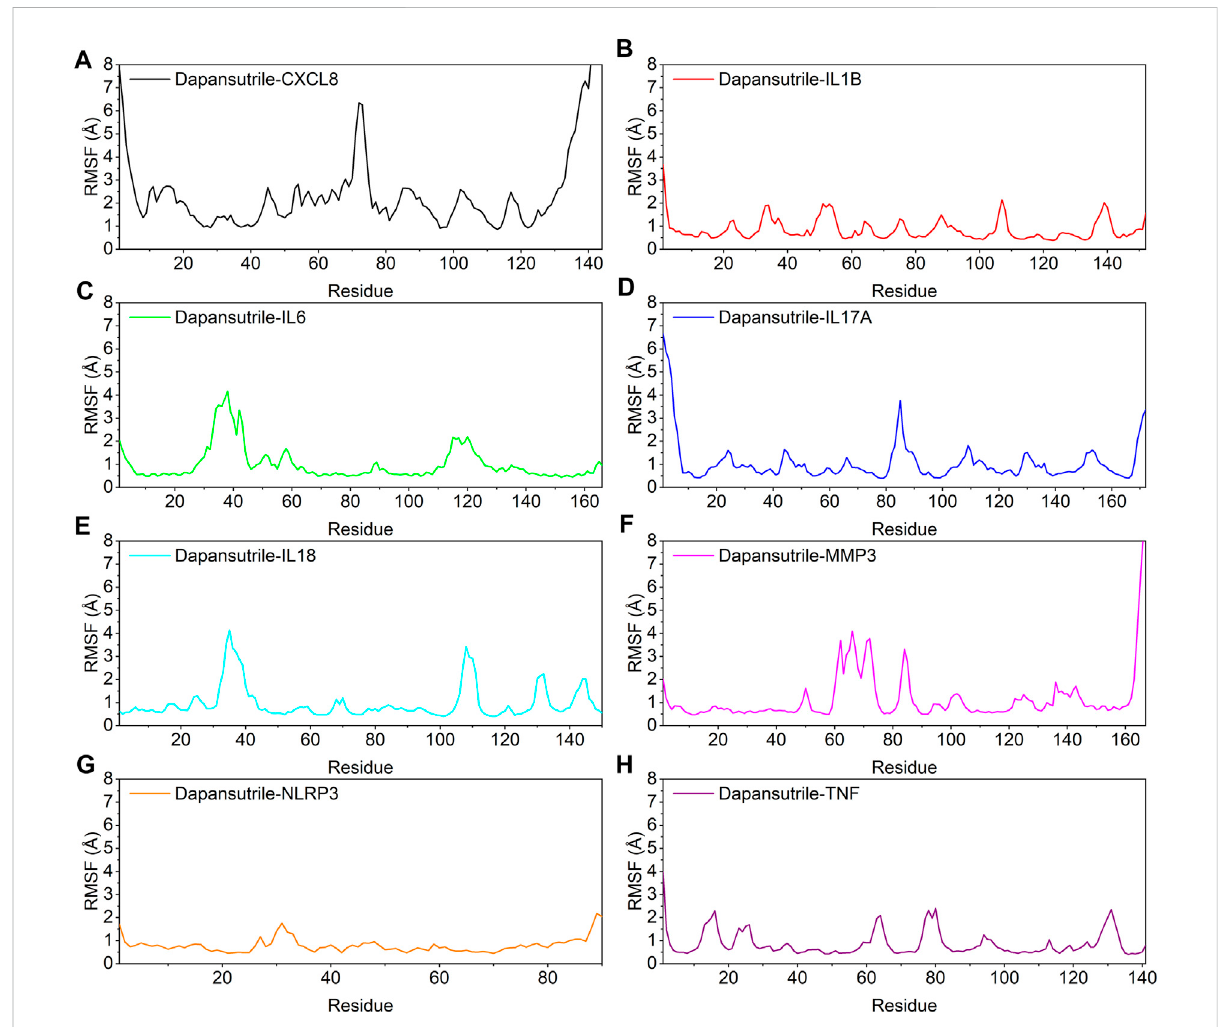
FIGURE 7 Changes in the stability of protein targets at the residue level (A) Dapansutrile/CXCL8, (B) Dapansutrile/IL1B, (C) Dapansutrile/IL6, (D) Dapansutrile/IL17A, (E) Dapansutrile/IL18, (F) Dapansutrile/MMP3, (G) Dapansutrile/NLRP3, (H)